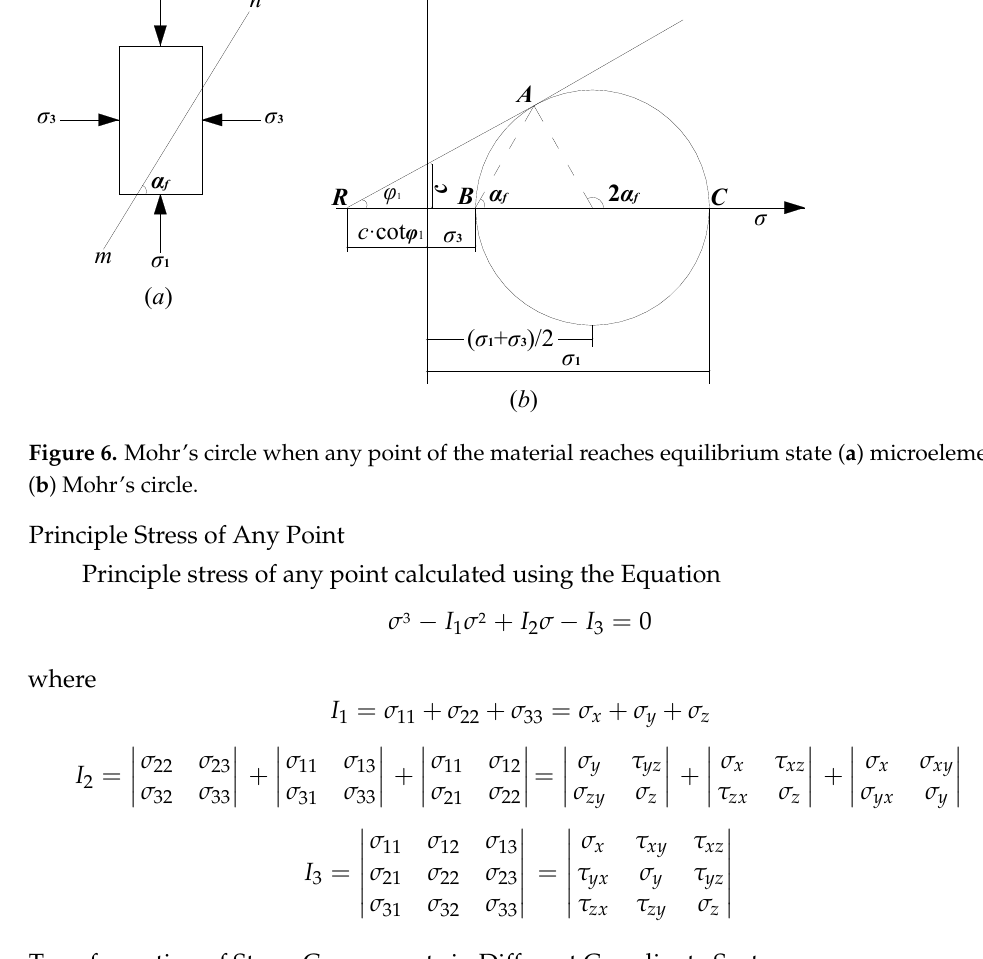
Figure 5. Mohr envelope.